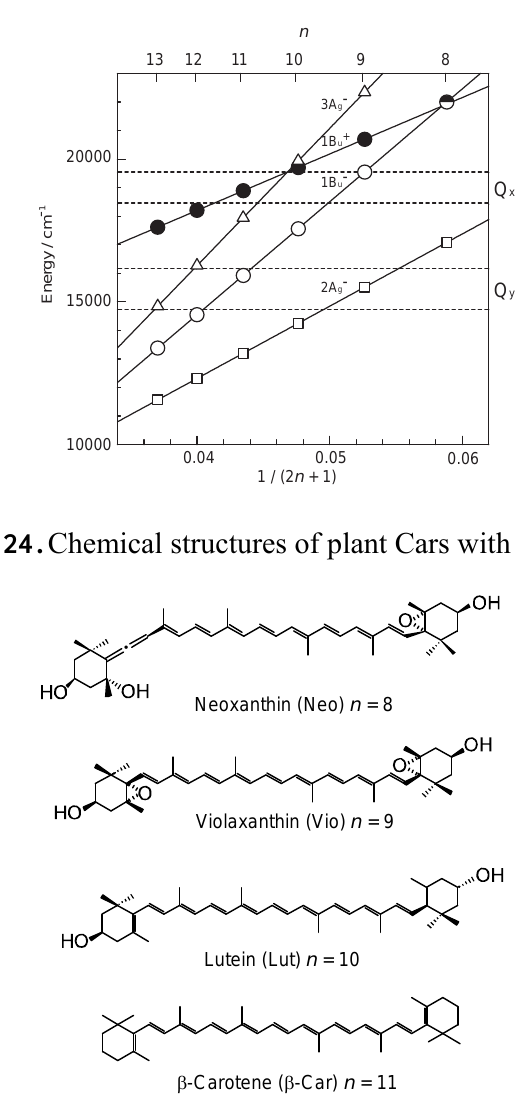
and Q states of Phe a (Phe y ). Shorter- x y